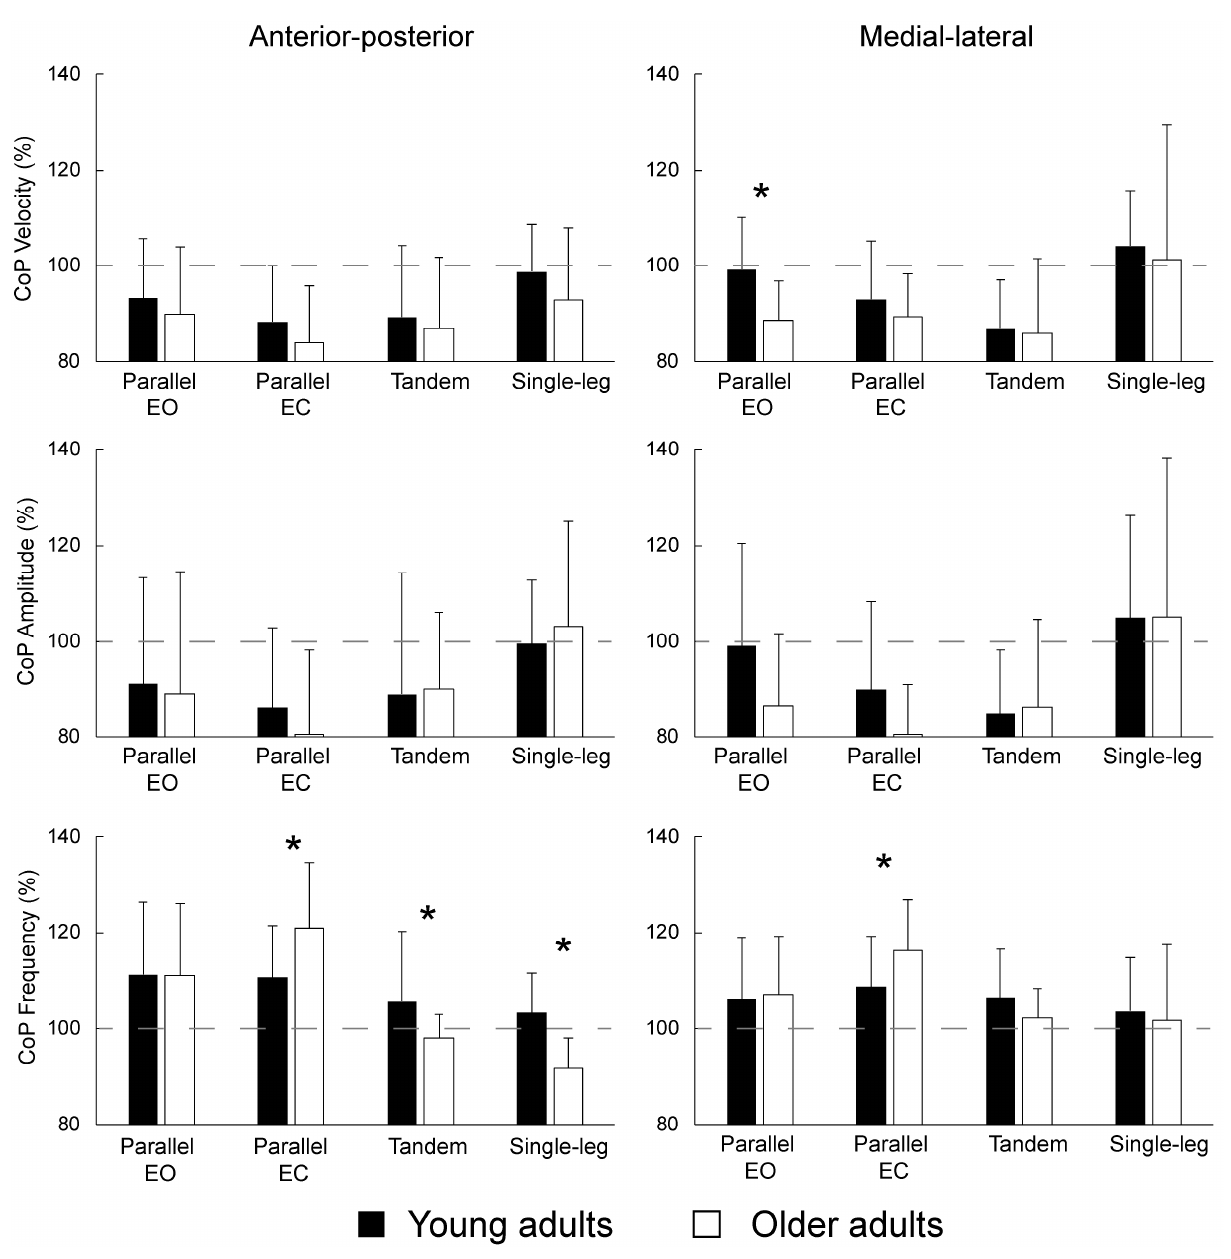
Figure 2. Comparison of DIF_21 index (relative difference between 2nd and 1st intervals of the trial) between young and older adults across tasks. CoP—center of pressure; AP—anterior–posterior; ML—medial–lateral; EO—eyes open; EC—eyes closed. The dashed line indicated the value corresponding to no transient response (i.e., the same value of postural sway in 1st and 2nd intervals). * Indicates statistically significant difference between the young and older group ( p < 0.05).